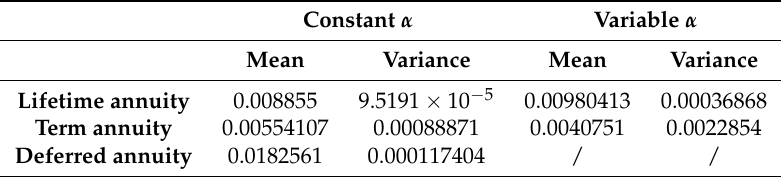
Figure 6. Density of the internal rate of return for α = 99.5% and r = 1%. Table 3. Mean and Variance of the internal rates of return (IRRs) for the three